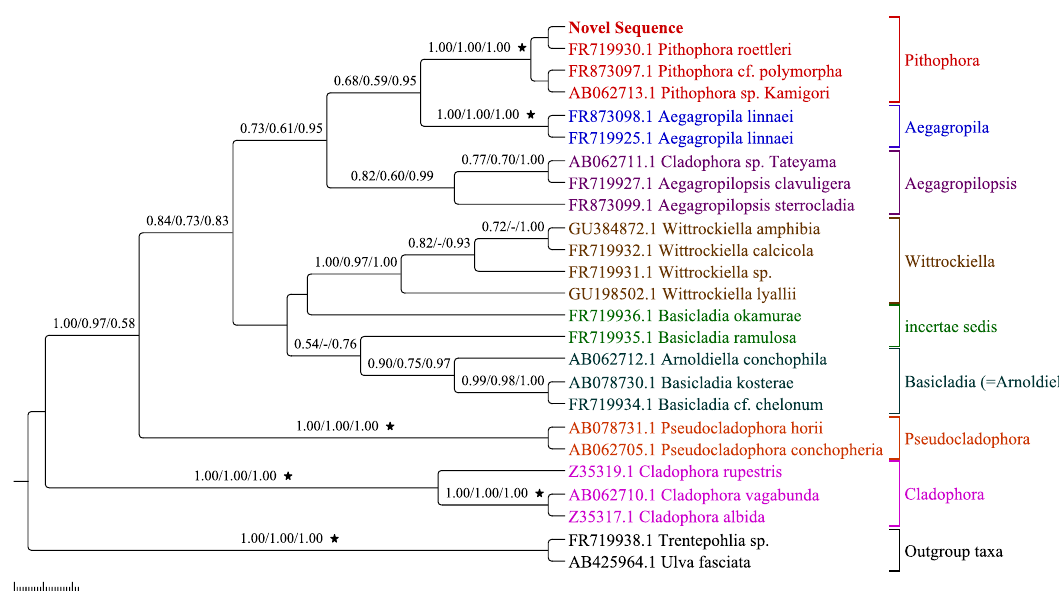
Figure 6. The most resolved concatenated LSU-SSU tree (ML) inferred with the novel sequence of Pithophora roettleri shown in bold as “Novel Sequence.” The bootstrap values of ML and MP and posterior probabilities of BI greater than 0.50 are given above each branch as (ML/MP/BI). Branches with highest support values are noted with stars. Hyphens (-) indicate a branching order that does not exist for that particular inference method.